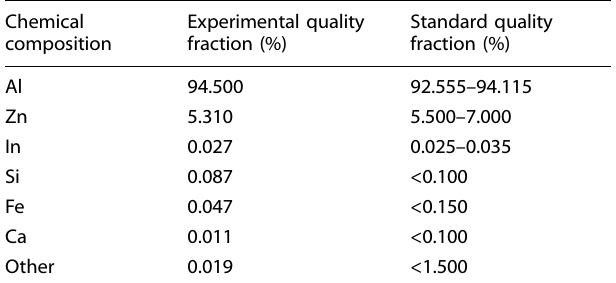
Table 1. Composition of the Al-Zn-In-Si sacri fi cial anode A13. Chemical